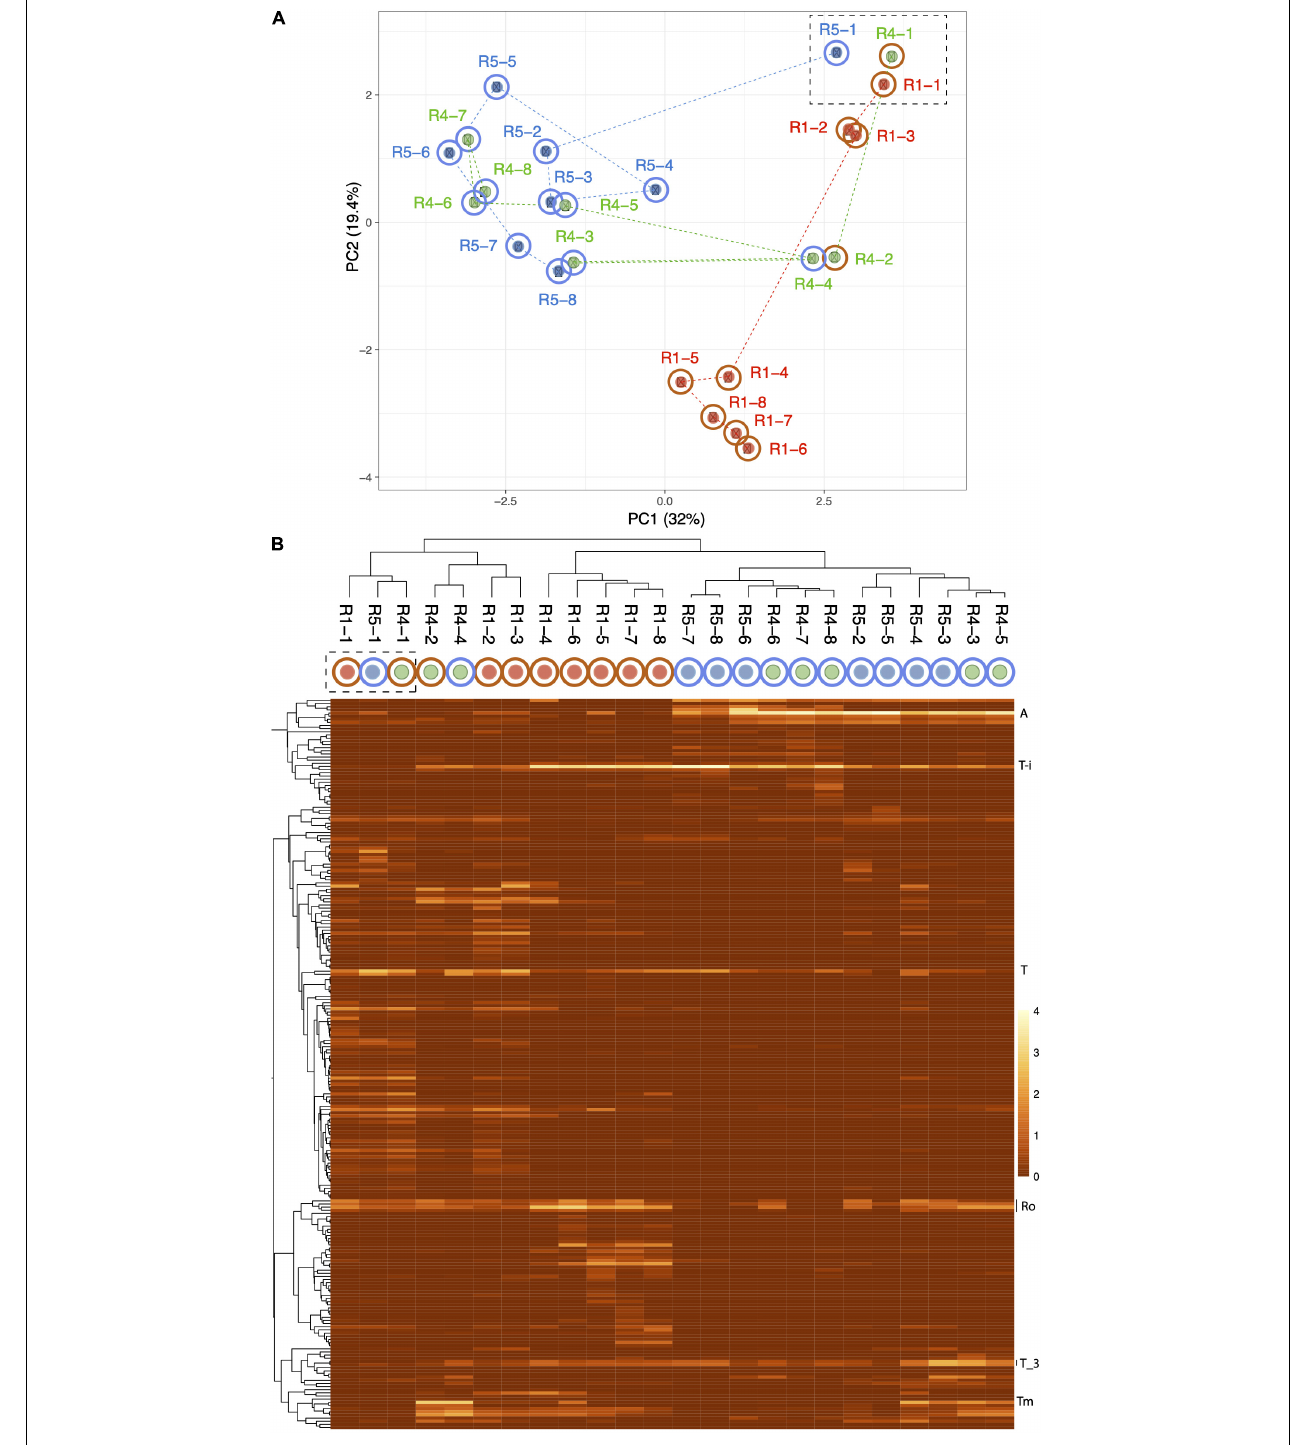
FIGURE 6 | Principal component analysis based on the relative abundances of 232 organisms (accounting for the most abundant 70–80% of the community) in reactors 1 (red dots), 4 (green dots), and 5 (blue dots). The dashed box indicates the first samples from each reactor. Note the dramatic divergence of R5 after ramping from 50 to 250 ppm SCN − in the absence of molasses, and the convergence of R4 with R5 after termination of molasses input. (B) Heat map showing clustering of samples based on the abundance of each of the 232 organisms. The proliferation of Afipia _64_1782 (A) separates most molasses-free (blue outer circle) from molasses-amended (brown outer circle) communities. Other abundant organisms include Thiobacillus -i (T), two strains related to Thiobacillus _3 (T_3), and several Rhodanobacteraceae (Ro). Thiomonas (Tm) that is unusually abundant in R4-4 and may contribute to its unexpected clustering with R4-2.